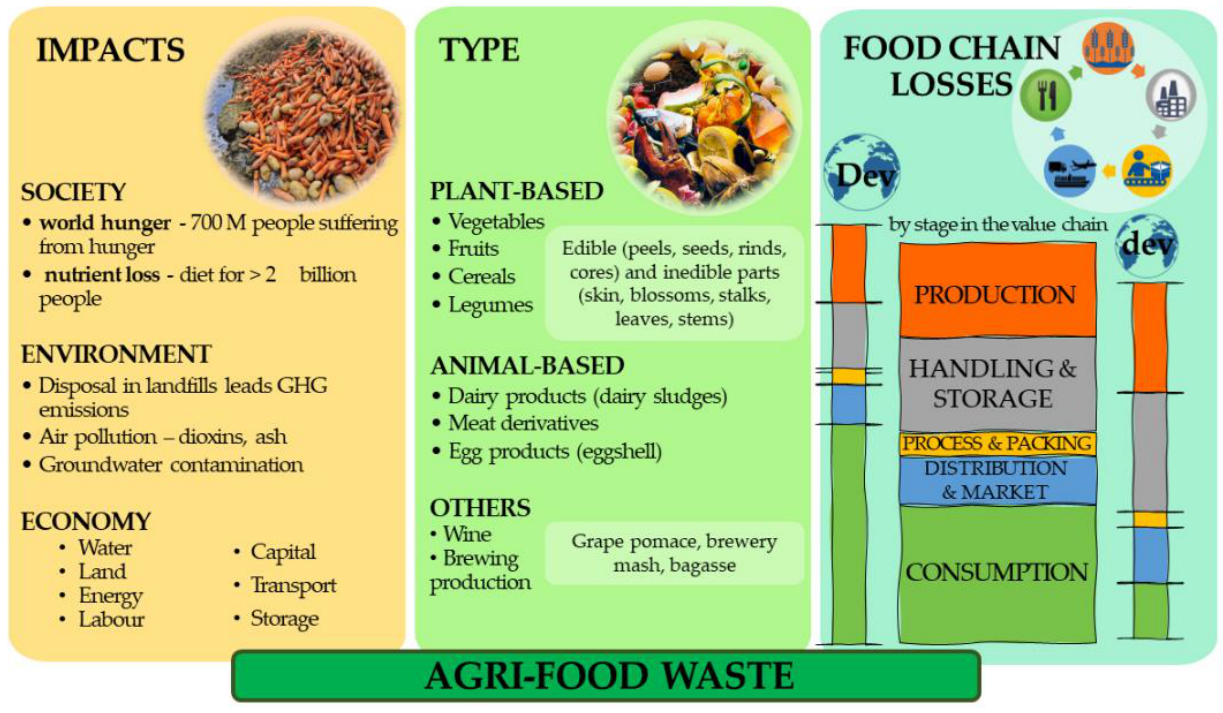
Figure 1. Overview of food waste impact, type, and food chain losses by stage in the value chain in developed (Dev) and developing (dev) countries [2].